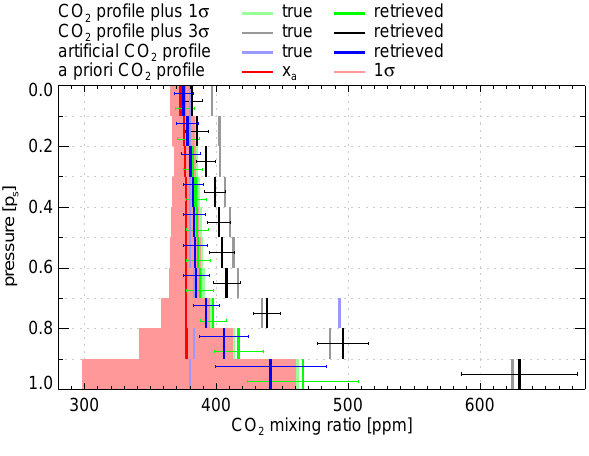
Fig. 8. Retrieved and true CO 2 mixing ratio profiles of the three “CO 2 profile”